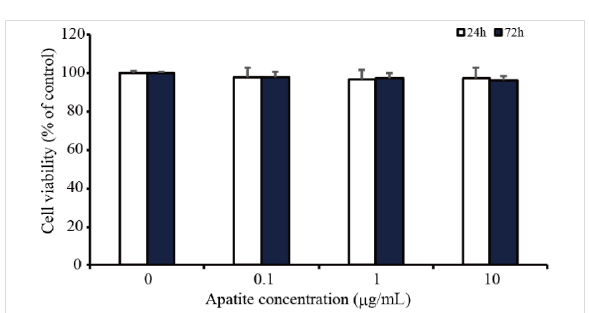
Figure 2: MTT assay of HL-1 cells treated with HAp nanoparticles for 24 (white bars) and 72 h (black bars) was used to determine cytotoxici- ty. Non-treated cells were used as the control. Values are presented as the mean ± SD ( n =